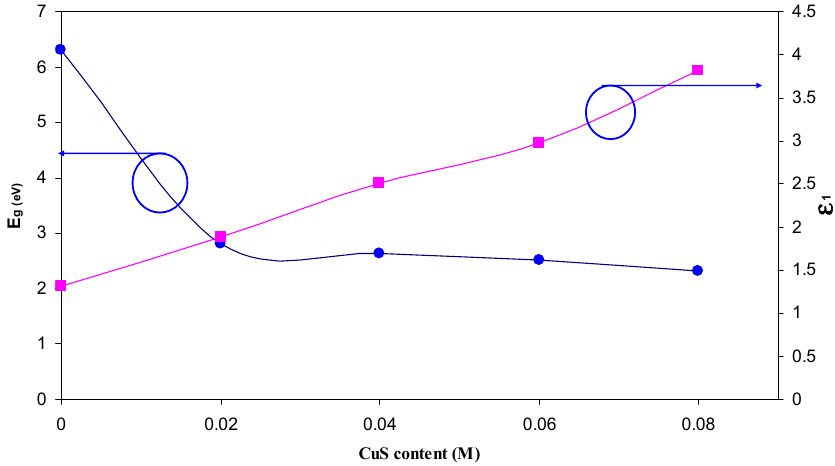
Figure 9. Energy bandgap and optical dielectric constant versus CuS concentration.